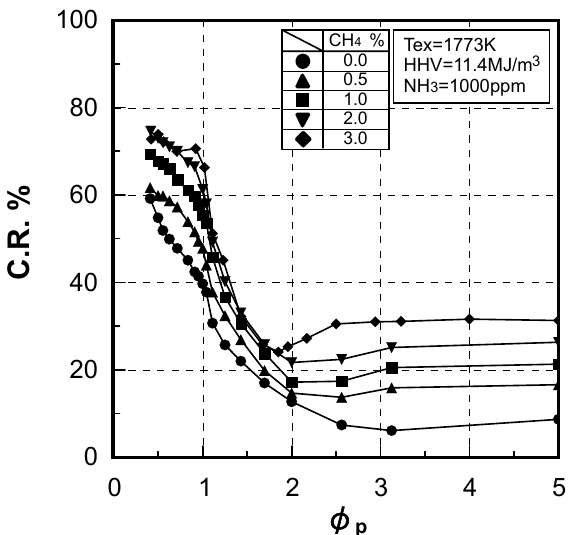
Figure 25. Effect of CH combustion of medium-Btu